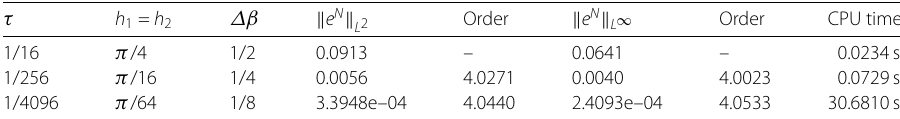
Table 4 Errors and convergence orders of scheme (45)–(46) with an optimal step size ratio for τ , h 1 , h 2 and Δβ (Example